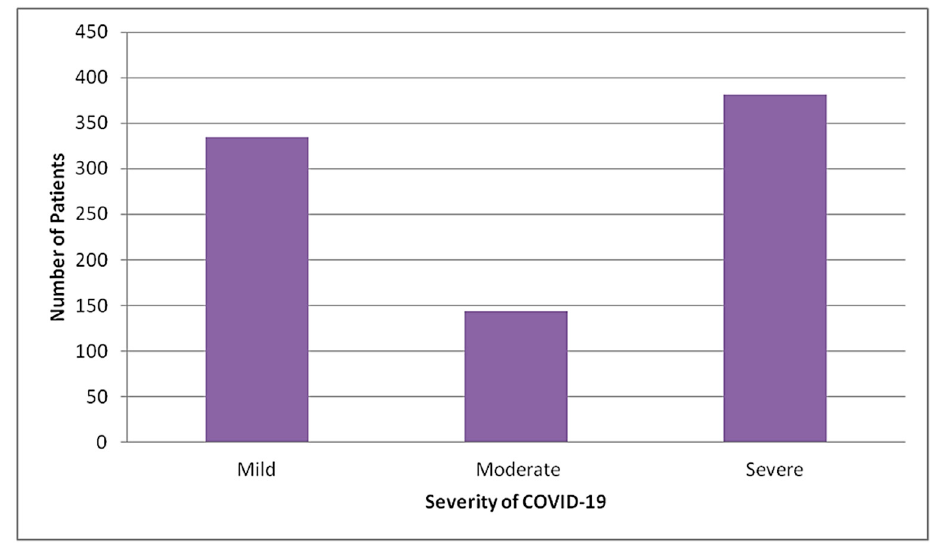
Figure 2. Distribution of total patients admitted in STIDH by severity of COVID-19 (N = 860).